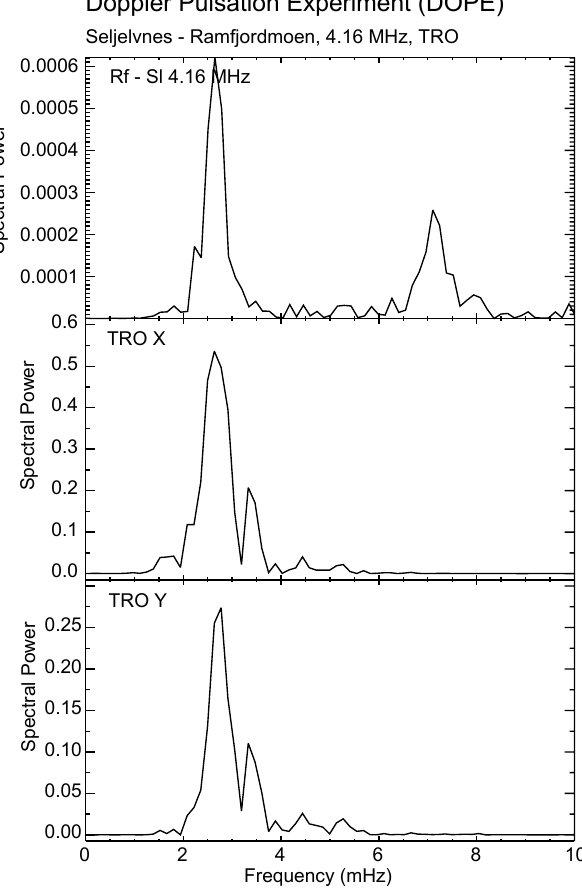
Fig. 2. Power spectrum of the magnetometer and DOPE data shown in Fig.